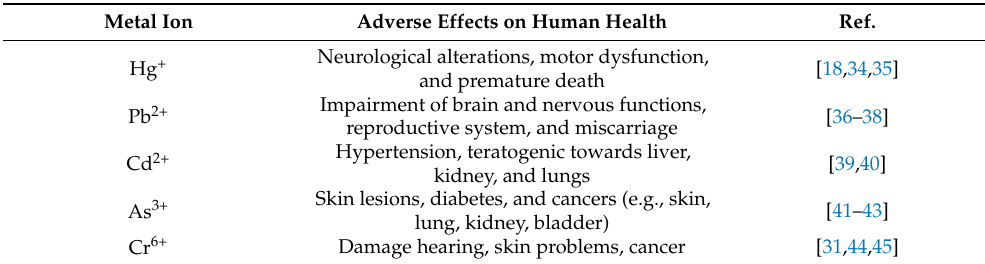
Table 2. Adverse effects of different metal ions on human